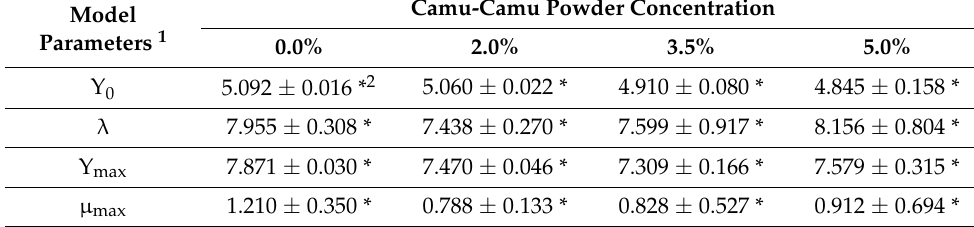
Table 4. Kinetic parameters of the Huang growth model describing psychrotrophic bacteria concen- trations in vacuum-packed ground beef containing different camu-camu powder levels stored at 5 ◦